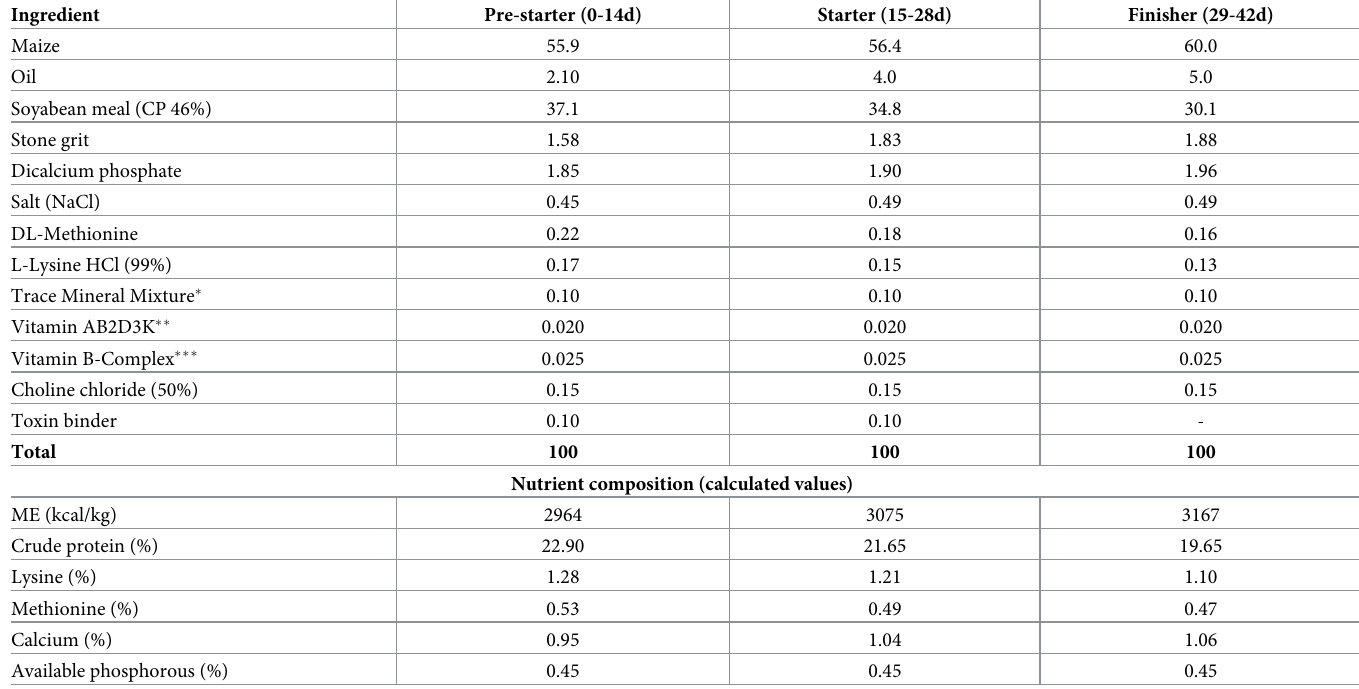
Table 1. Ingredient composition of basal diets (in kgs) fed to the commercial broilers from